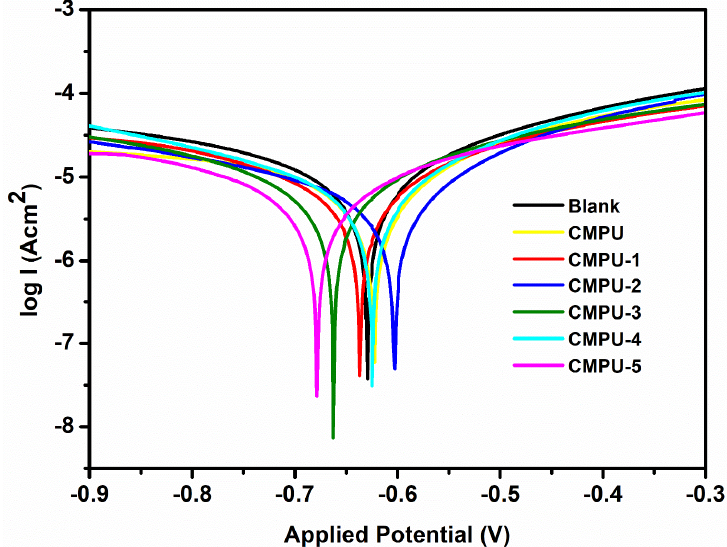
Figure 8. Tafel plot of CMPU, CMPU-1, CMPU-2, CMPU-3, CMPU-4, and CMPU-5 coated samples in aq. 3.5% NaCl medium. Table 5. Electrochemical corrosion measurement of bare, CMPU, CMPU-1, CMPU-2, CMPU-3, CMPU-4, and CMPU-5 coated